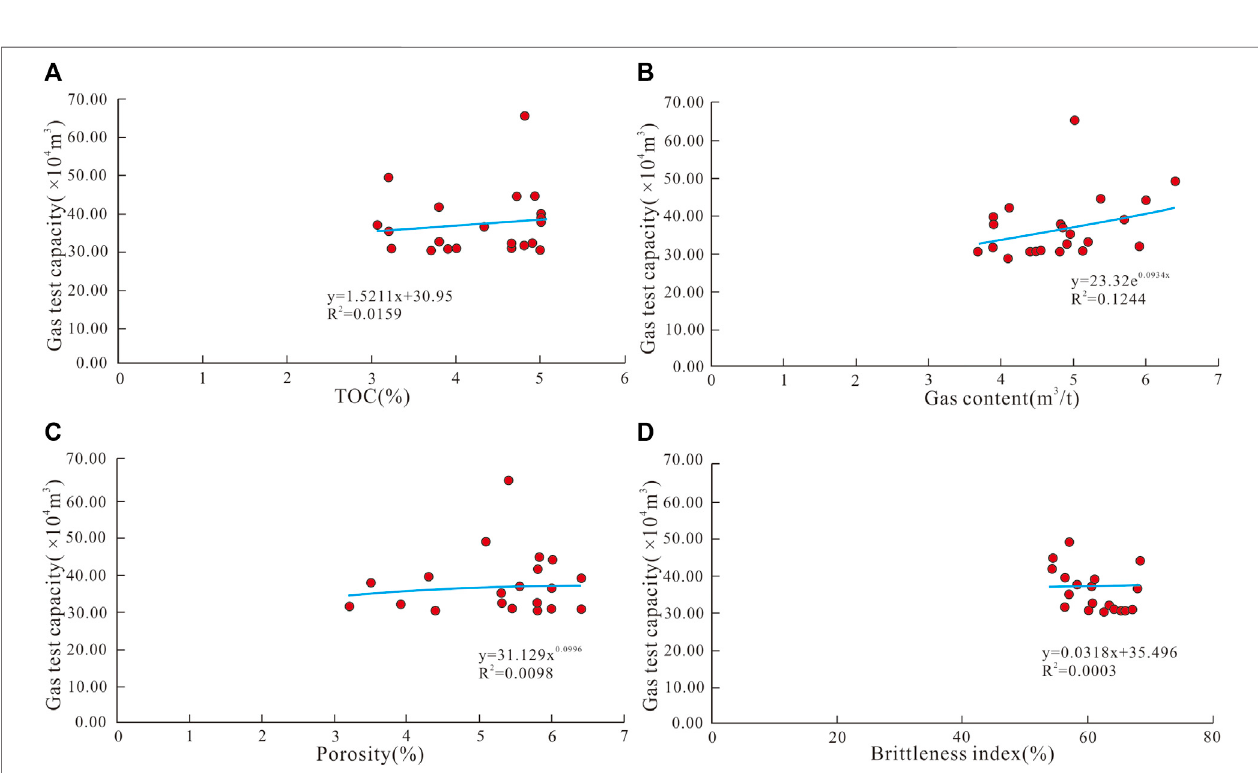
FIGURE 12 | Relationship between test production above 300,000 m 3 and reservoir physical properties in the study area.